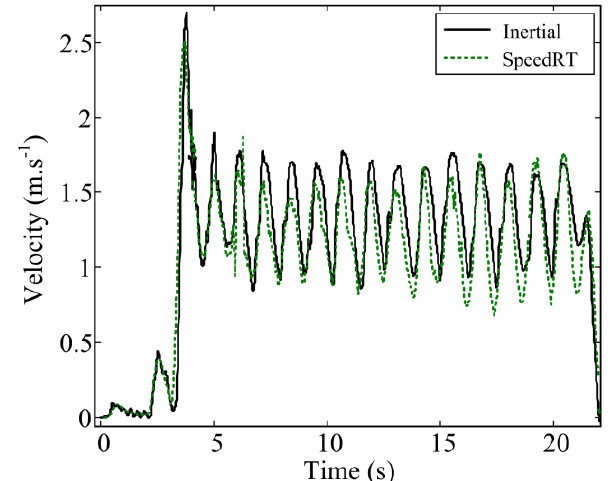
Figure 4. A typical result of velocity calculation using IMU (Solid line) compared to the reference tethered apparatus (dotted